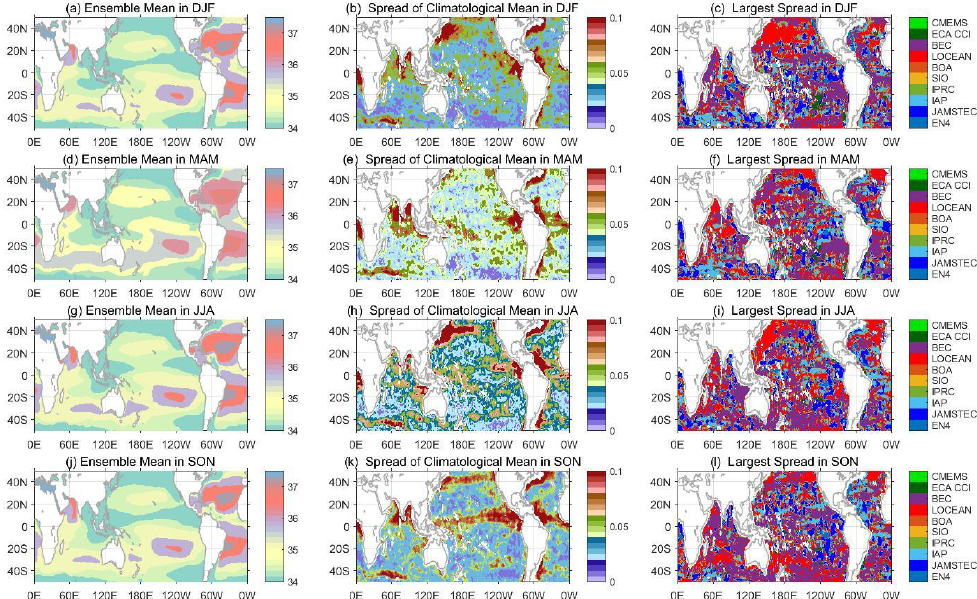
Figure A1. The horizontal distribution of the ( a , d , g , j ) ensemble means, ( b , e , h , k ) STD, and ( c , f , i , l ) largest spread of seasonal SSS derived from ten products averaged over 2011–2018.